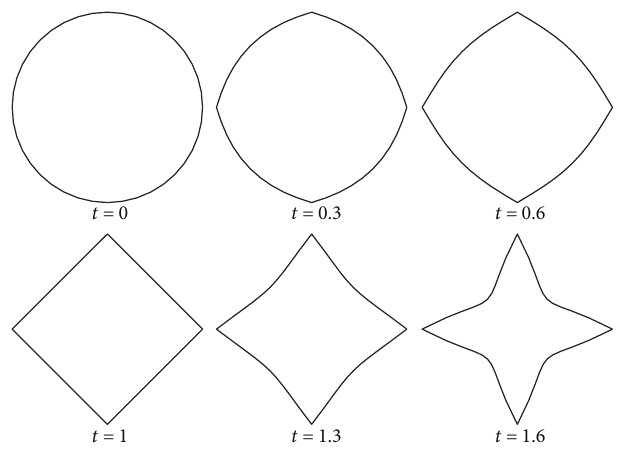
Figure 4: Blended results between a circle and a diamond with a variation of t values.